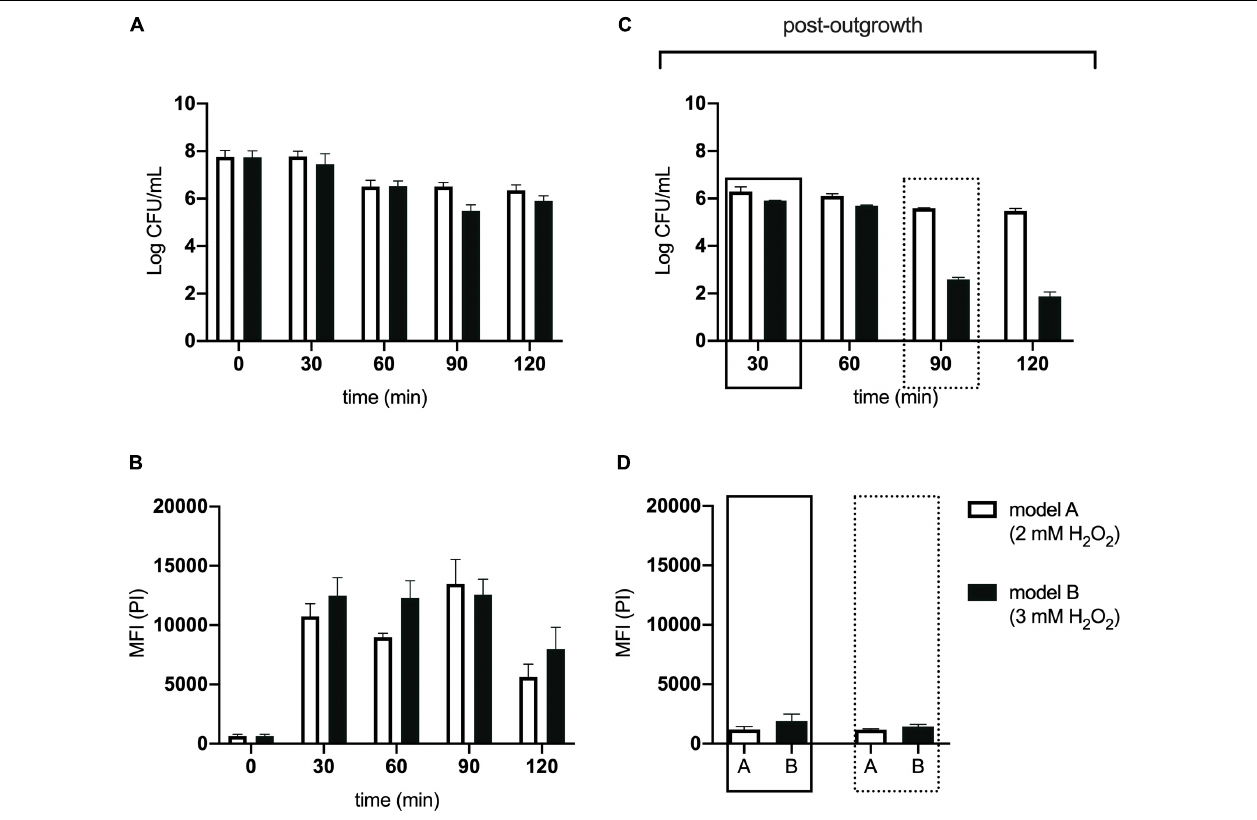
FIGURE 1 | Antibacterial effect of model honeys on E. coli . Colony counts, showing the cell survival (A) , and mean fluorescence intensity (MFI) of PI, showing the extent of cell wall damage (B) , are plotted for 30, 60, 90, and 120 min post-exposure to honey model honey A (plain bars) and B (black bars). Colony counts (C) show the survival of the four treated populations after 2 h outgrowth in LB and the MFI of PI (D) of 30 min- and 90 min-treated population post- 2 h outgrowth in fresh LB. Error bars show standard deviations, ( n = 3; biological